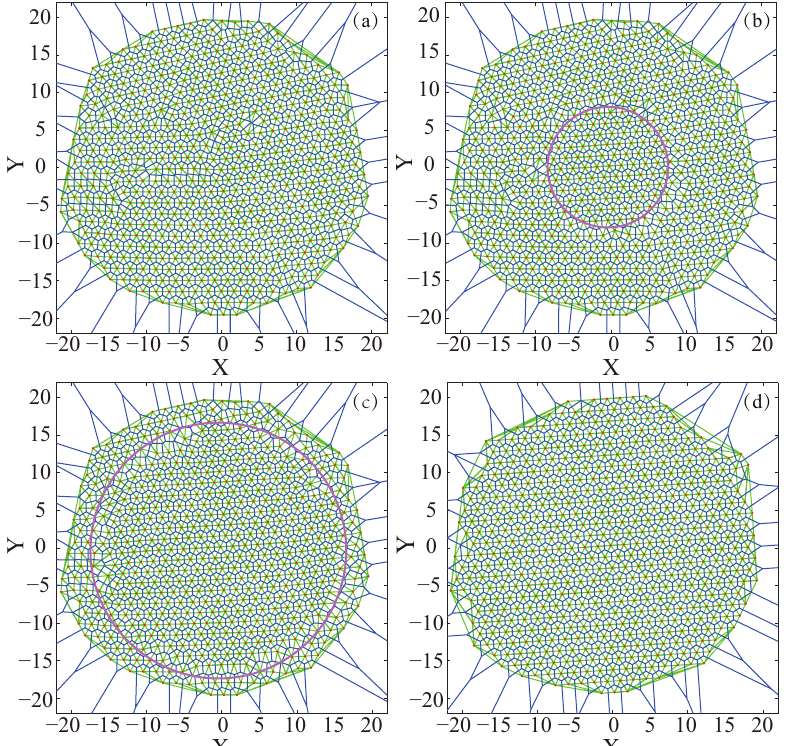
Figure 7. The node distribution in VFA-SF-OPT process: ( a ) initial distribution from VFA-SF at the 800th time step; ( b ) the distribution from VFA-SF-OPT at the 600th time step where only the nodes in the pink circle participated in this optimization algorithm, as time goes on, more and more sensor nodes are involved in the deployment algorithm until they are all involved. ( c ) the distribution from VFA-SF-OPT at the 1200th step; ( d ) final distribution from